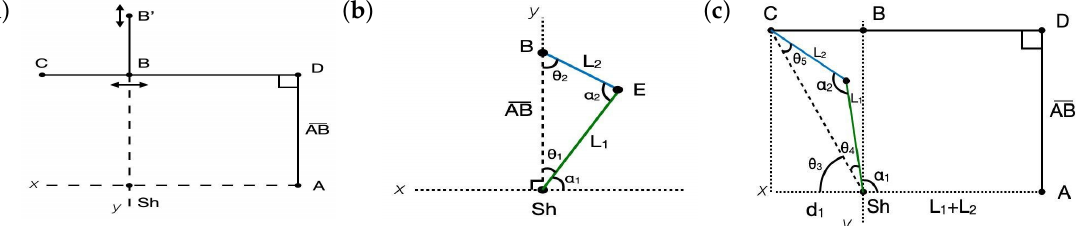
Figure A2. A top view representation of the structure and the generated angles by the arm: ( a ) The solid black line represents the structure and its properties, and the dotted line represents the pose that the user must adopt in the main gestures. ( b ) Shows arm pose at the point B to estimate the length of the arm (green colour) and forearm (blue colour) with the known distance AB . ( c ) Gesture performed for redundant calculation towards point C